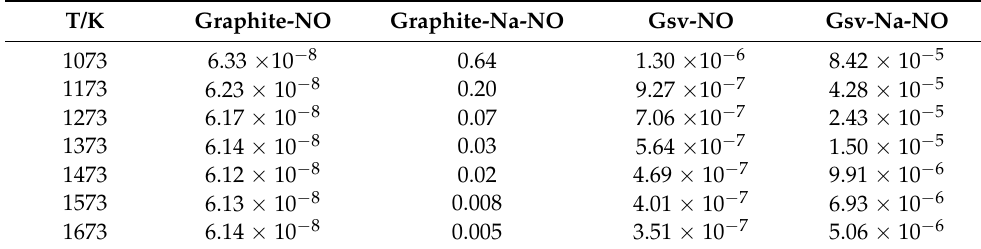
Table 3. Reaction equilibrium constant of every reaction. T/K